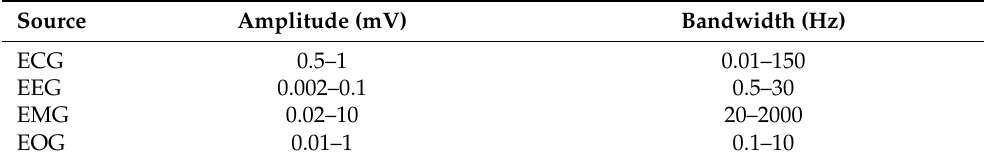
Table 1. Voltage and frequency parameters of some common biopotential signals [6] .